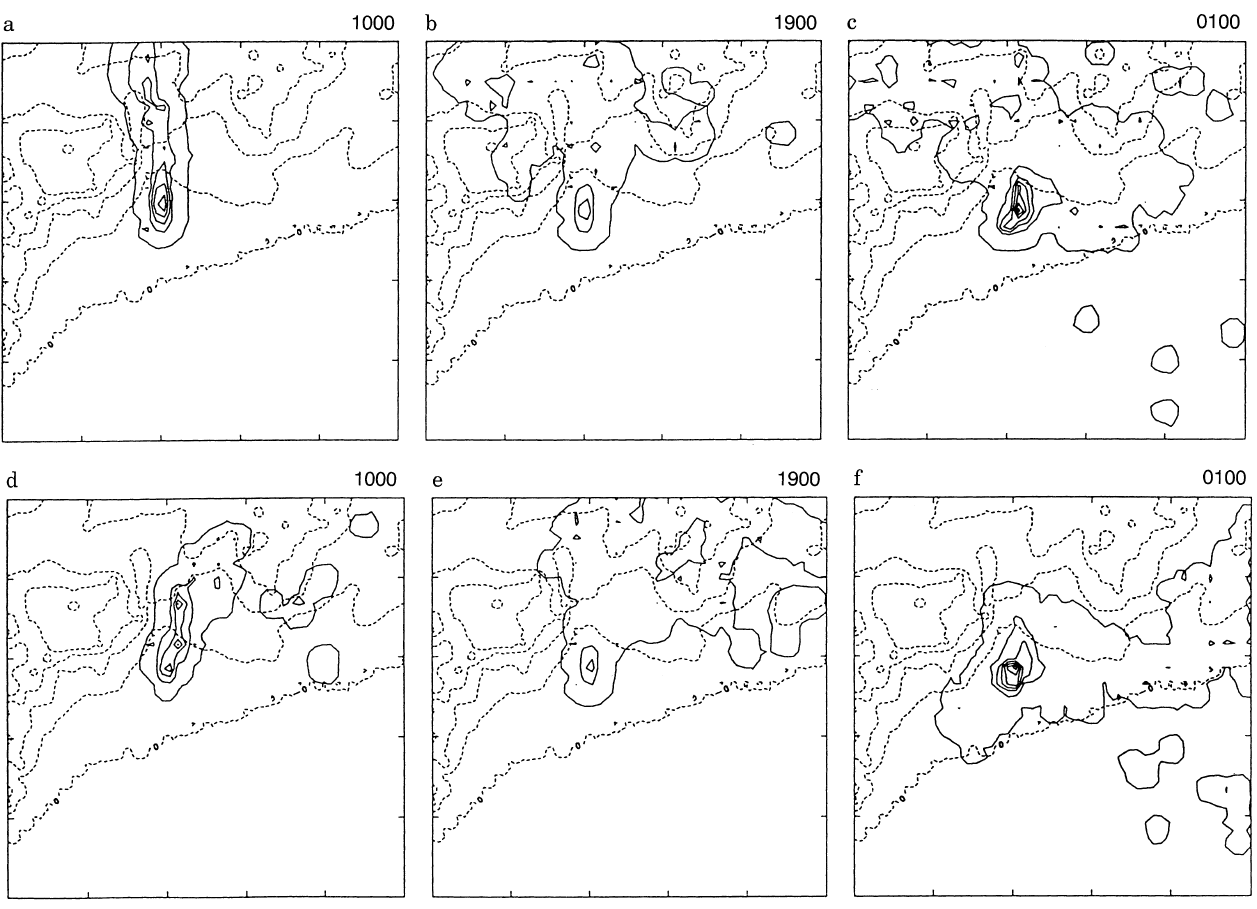
Fig. 11a-f. Ground level concentration for a 1000 LST, E1; b 1900 LST, E1; c 0100 LST, E1; d 1000 LST, E2; e 1900 LST, E2; f 0100 LST, E2. Contour concentration starts at 1 (cid:108) g m (cid:41) 3 and the interval is 20 (cid:108) g m (cid:41) 3 at 10 LST and 50 (cid:108) g m (cid:41) 3 at 1900 and 0100 LST